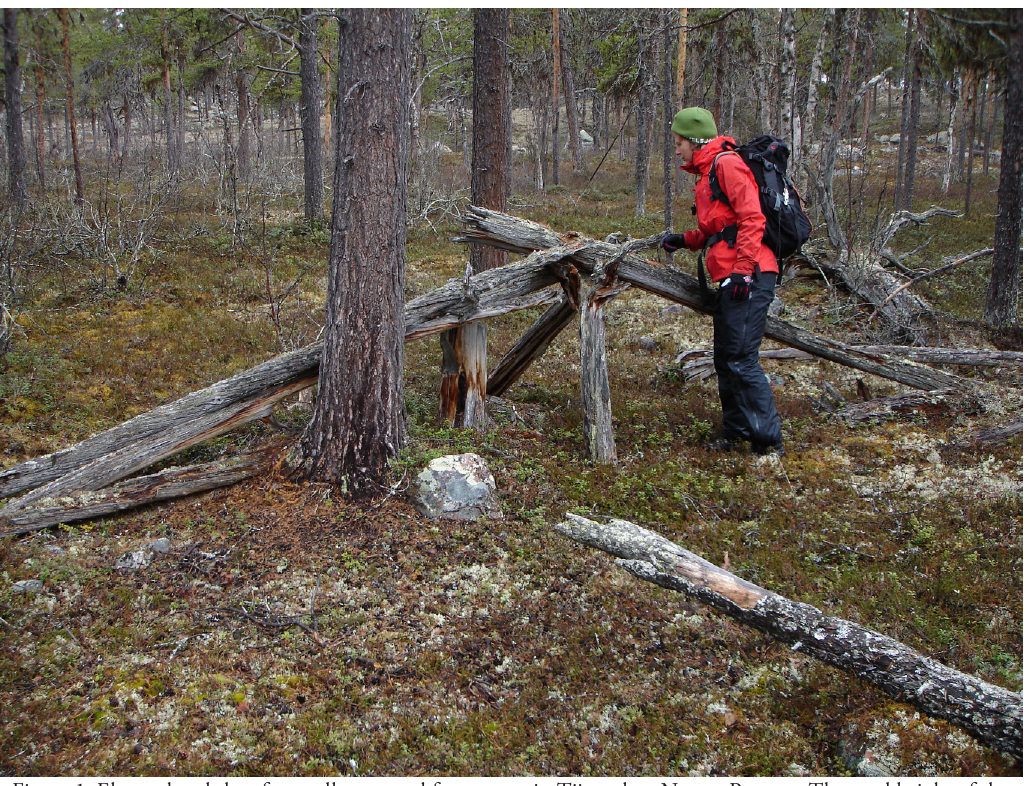
Figure 1. Elevated and therefore well preserved fence parts in Tjieggelvas Nature Reserve. The total height of the fence is here about 1.1